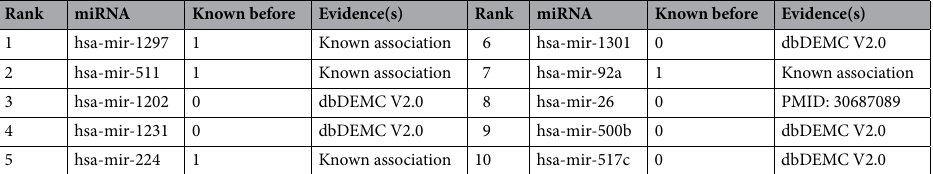
Table 6. Top 10 predicted lung neoplasms-associated miRNAs in the simulated experiment for predicting new disease-related miRNAs.